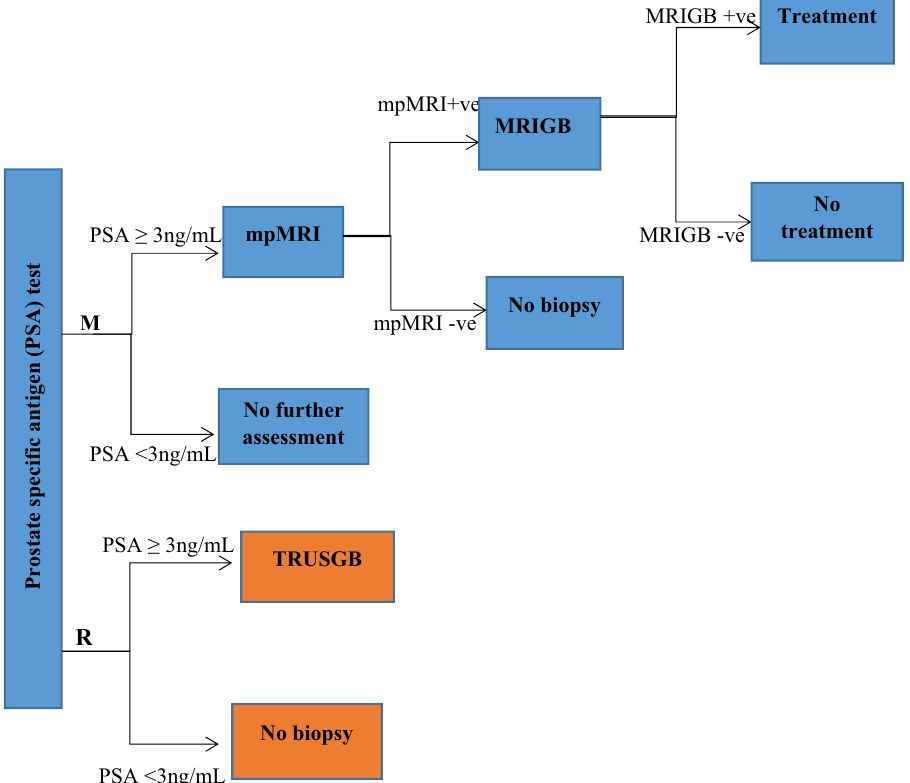
Figure 1. Schematic representation of the MRI pathway (M) and regular pathway (R). mpMRI multi parametric magnetic resonance imaging, MRIGB magnetic resonance imaging-guided biopsy, MRI magnetic resonance imaging, TRUSGB transrectal ultrasound-guided biopsy.